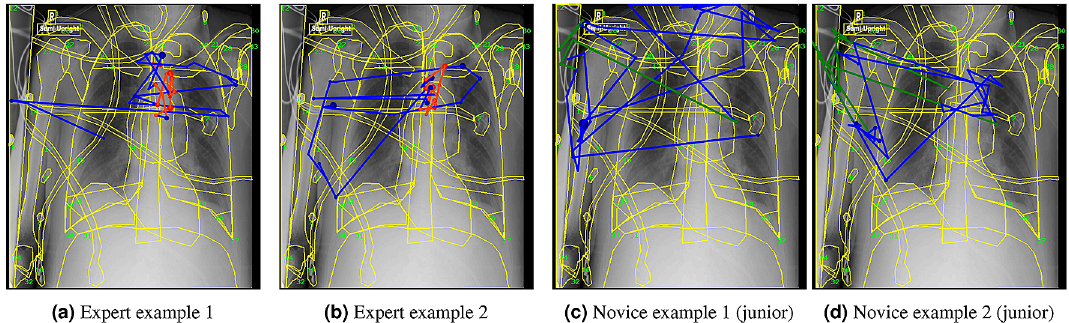
Figure 3. Example eye movement sequences for Task 7. The red subsequences of experts show close examination of the potential diseased area, while the novices are distracted by the technical imperfections at the left edge (green subsequences).